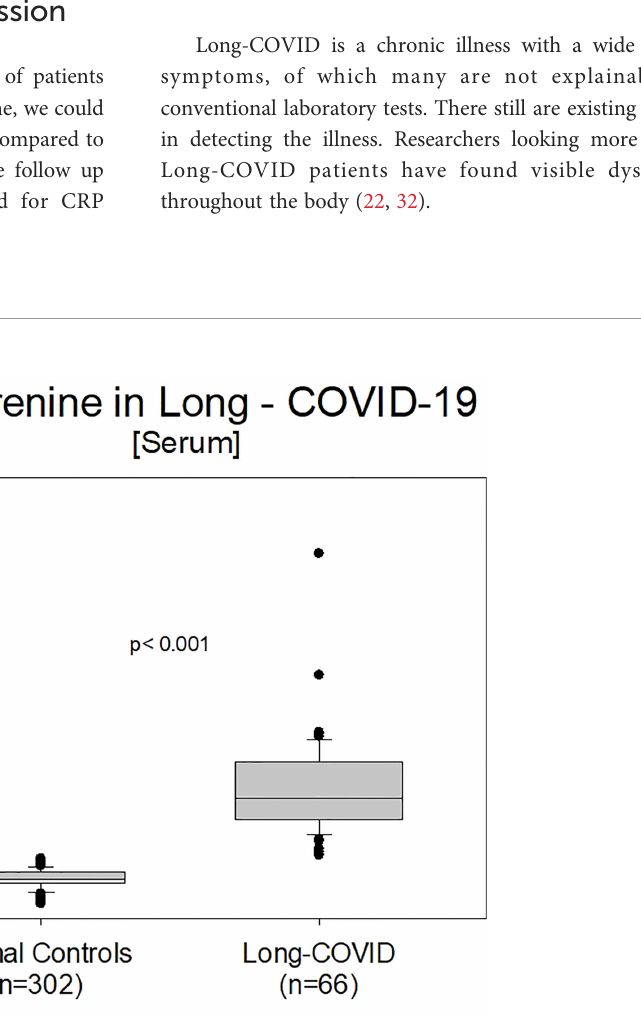
FIGURE 3 Comparison of kynurenine values between normal controls (n=302) and previously positive COVID-19 patients (Group B, n=66) with an existing Long-COVID syndrome (p<0.001). Patients with the LCS were currently under therapeutic